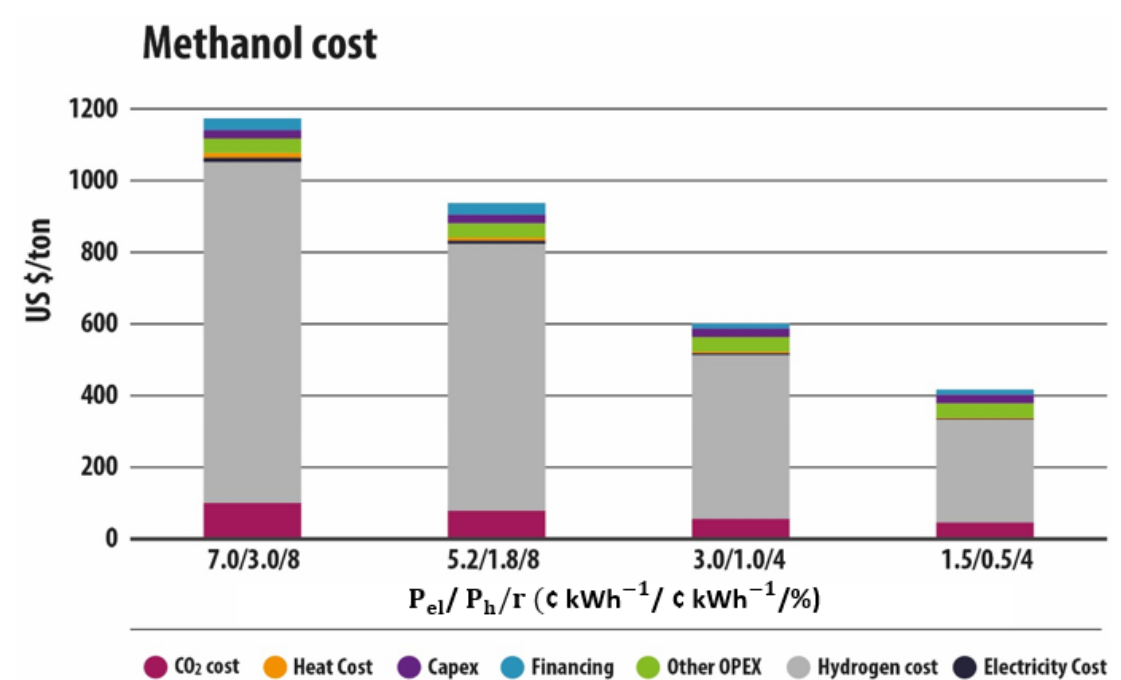
Figure 3. Methanol cost break down for different electricity and heat prices and discount rates.